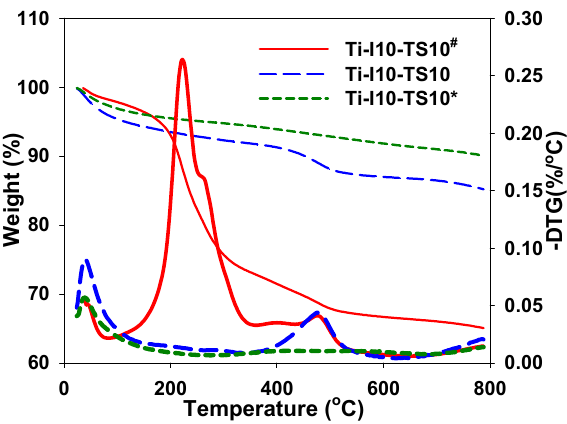
Figure 1. The TG and DTG curves for the as-synthesized, extracted and extracted calcined (350 and 600 °C) titania-silica composites.